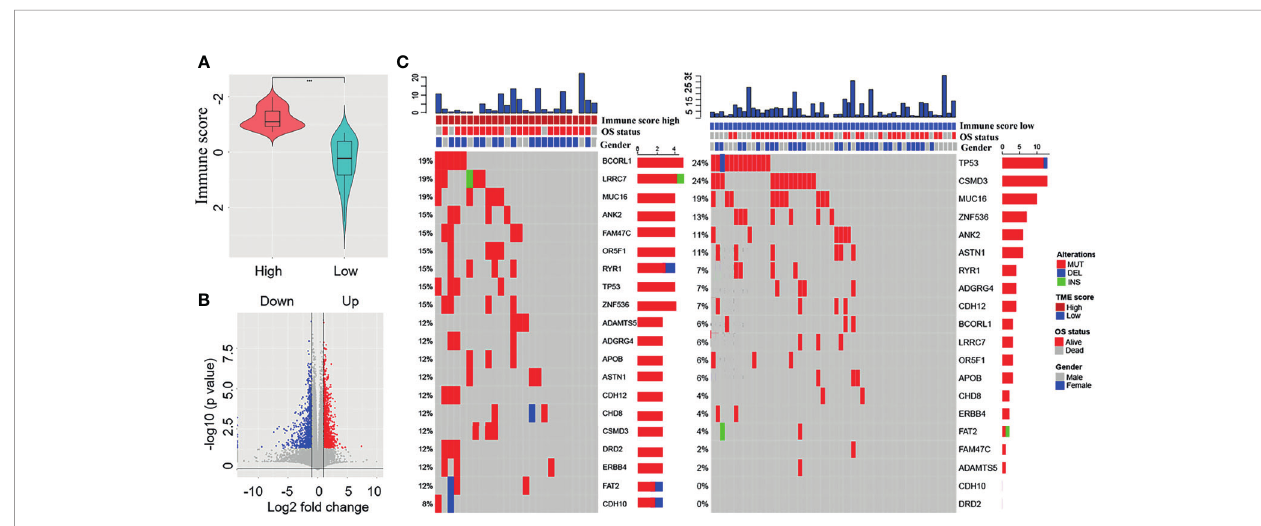
FIGURE 2 | Screening of differentially expressed immune-related genes and comparison of tumour mutation burden (TMB) between the high and low immune score groups. (A) Comparison of the immune scores between the high and low immune score groups. (B) Screening of differentially expressed immune-related genes between the high and low immune score groups (red colour represents upregulated genes and blue colour represents downregulated genes). (C) Comparison of overall survival status, gender, and TMB between the high and low immune score